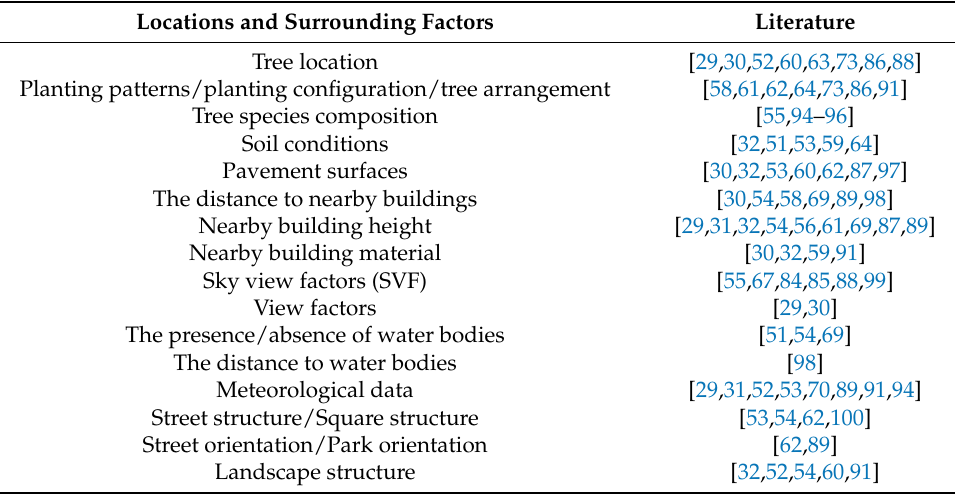
Table 5. Locations and surrounding factors of trees summarized from the